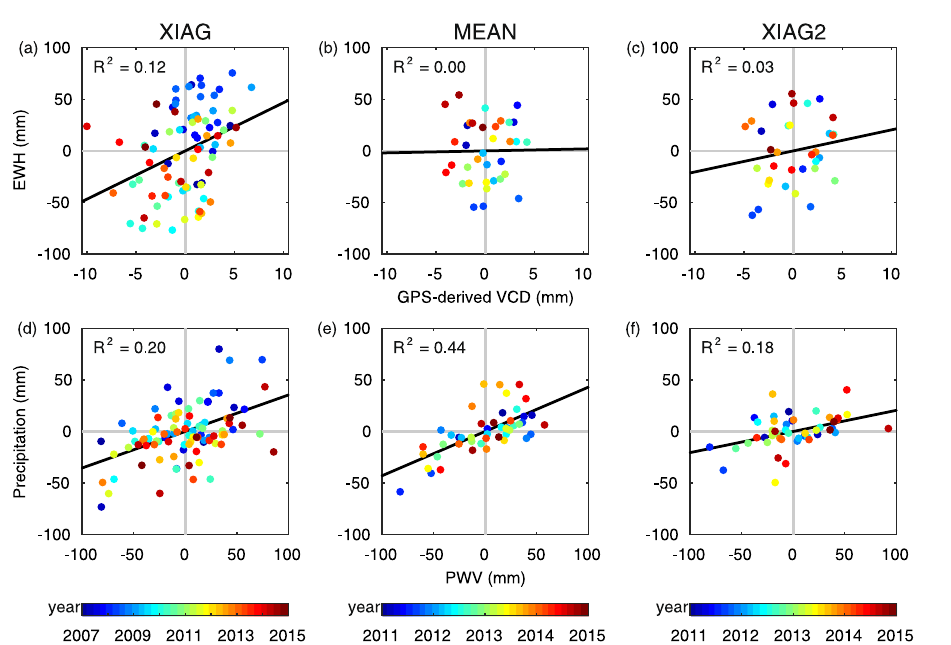
Figure 6. Scatterplots of GPS-derived VCD anomalies versus EWH anomalies and PWV anomalies versus precipitation anomalies at XIAG station and for MEAN. Anomalies obtained from the time series of XIAG station from 2011.0 to 2015.0 is termed as XIAG2 station in this